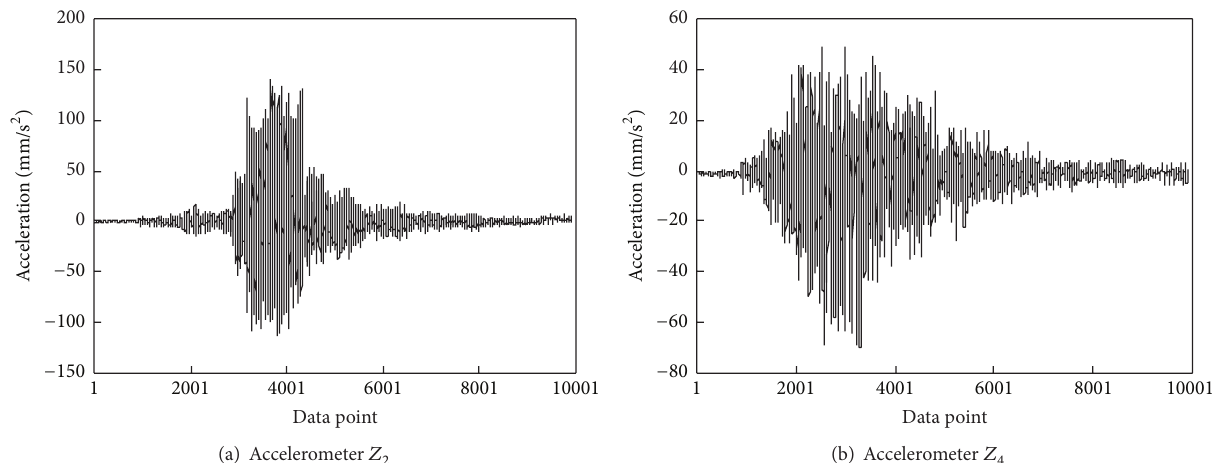
Figure 7: Vertical acceleration time histories of the main girder caused by a high-speed train.